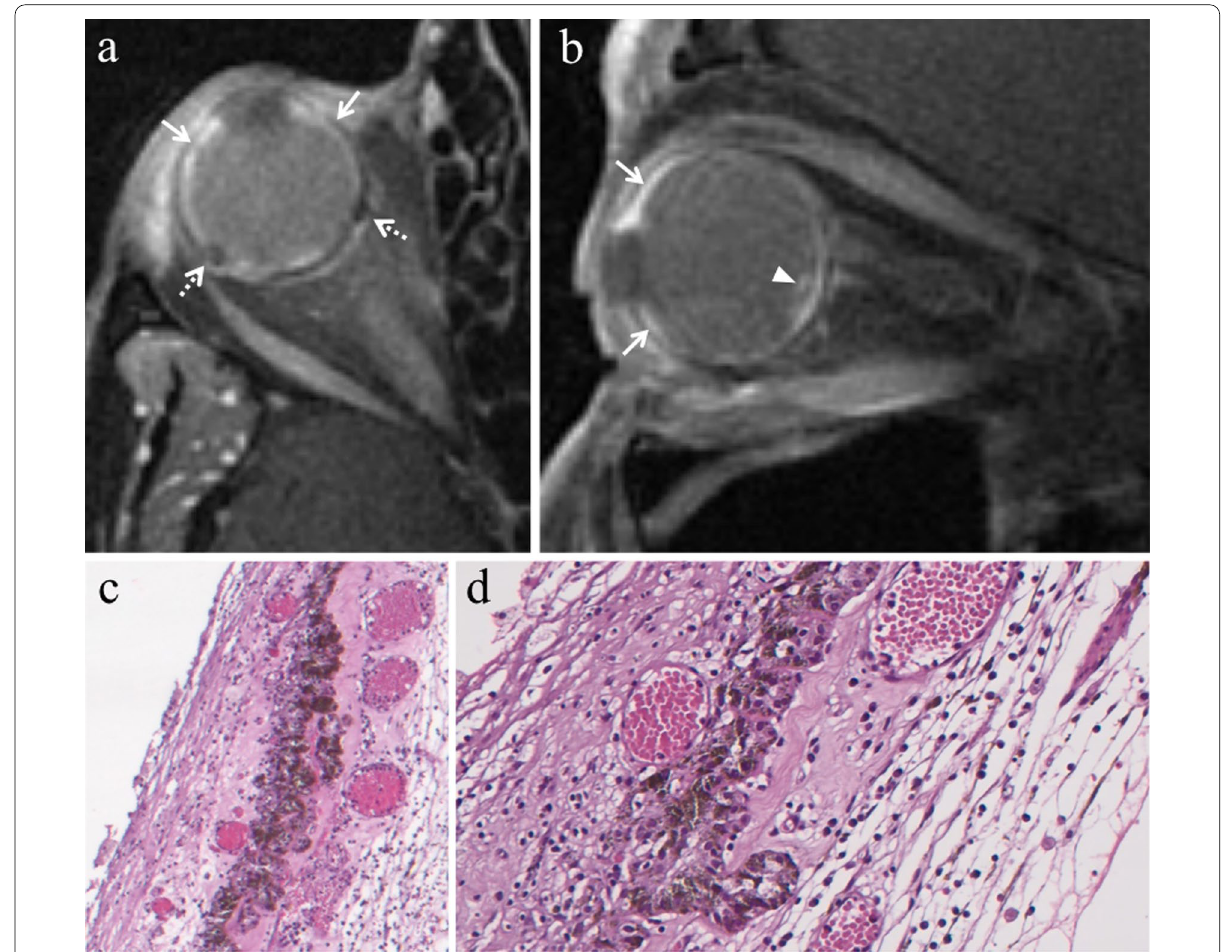
Fig. 13 A 58-year-old man with neovascular glaucoma after proton-beam radiotherapy for choroidal melanoma of the right eye. The same patient as in Fig. 6. a Axial and ( b ) sagittal contrast-enhanced fat-supressed T1-weighted images display marked enhancement of the ciliary body and the anterior portion of the choroid (white arrows), a finding consistent with anterior segment neovascularization leading to neovascular glaucoma. Note the residual irradiated tumor along the posterior aspect of the globe (white arrowhead in b ). Small hypointense artefacts produced by the tantalum clips are appreciable along the posterior edge of the sclera (white dotted arrows in a ). c Histological examination showing a florid angiogenic process surrounding a ciliary body (H&E, original magnification 150 ). d At higher magnification, angiogenesis consisting of numerous × congested end ectatic vessels is well documented (H&E, original magnification 400 ×